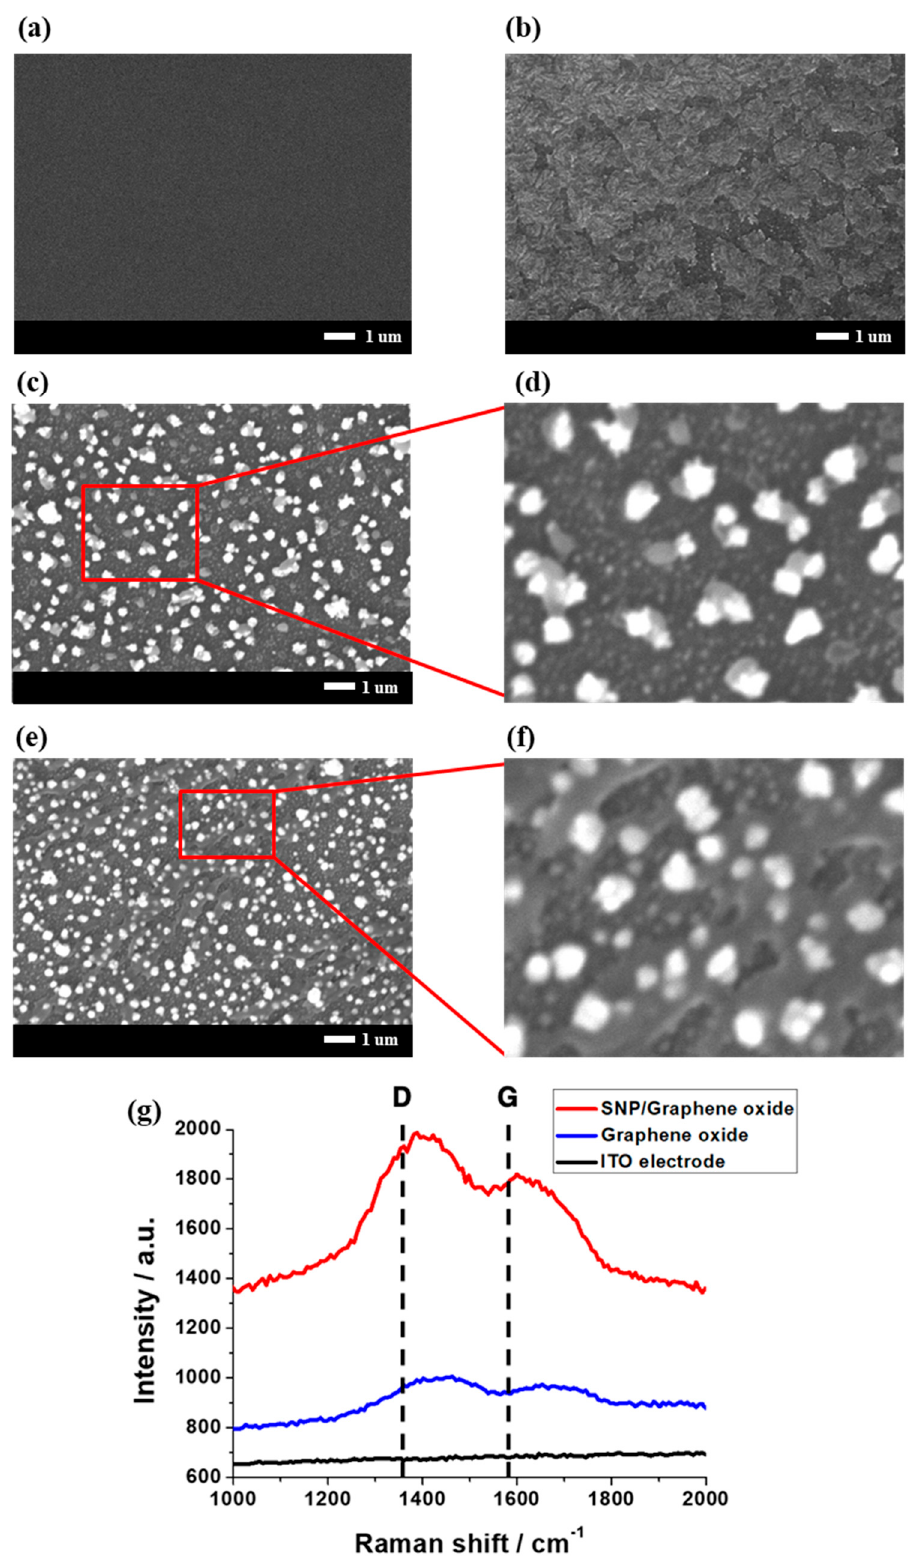
Figure 2. SEM images of the ( a ) ITO electrode; ( b ) ITO electrode covered by graphene oxide; ( c ) SNP modified electrode; ( d ) magnification of the SNP modified electrode; ( e ) SNP modified electrode covered by graphene oxide and ( f ) magnification of the SNP modified electrode covered by graphene oxide; ( g ) Raman spectroscopy of the ITO electrode, ITO electrode covered by graphene oxide and SNP modified electrode covered by graphene oxide.